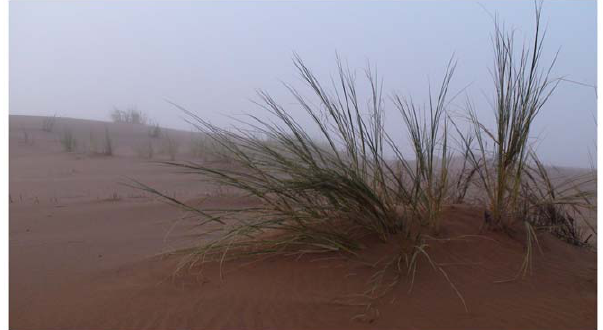
Figure 2. Namib dune bushman grass. A Namib dune bushman grass Stipagrostris sabulicola hummock in the fog. (plant height ca. 1 m).